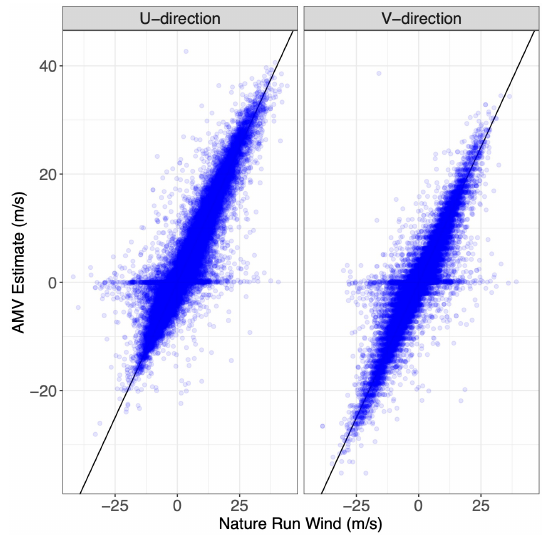
Figure 3. Scatterplot of the simulated Nature Run wind vs. AMV estimates for u and v wind in the training dataset.